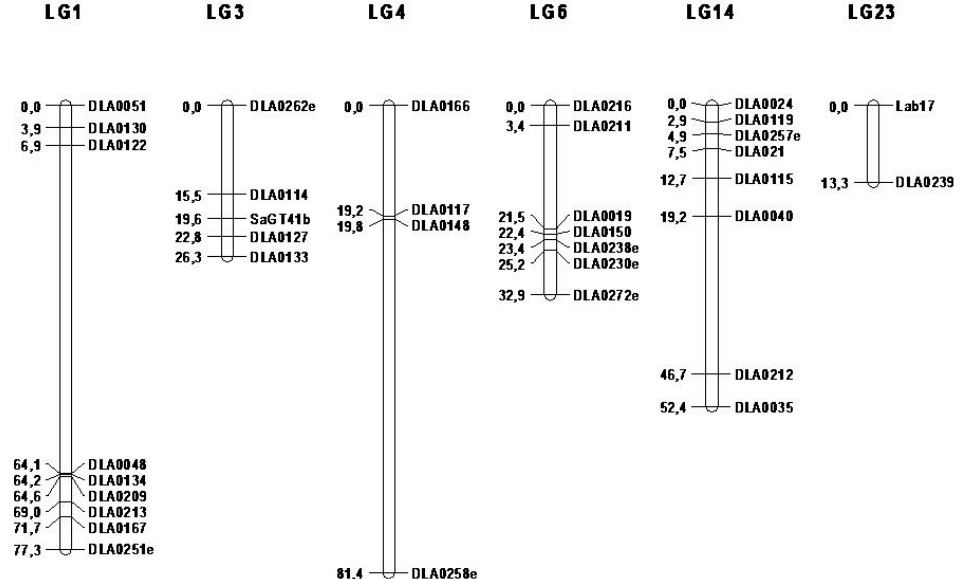
Figure 1. Sex-averaged genetic map comprising of 35 markers in six linkage groups. Linkage groups are named according to the first- and second-generation linkage maps of sea bass [26,27].